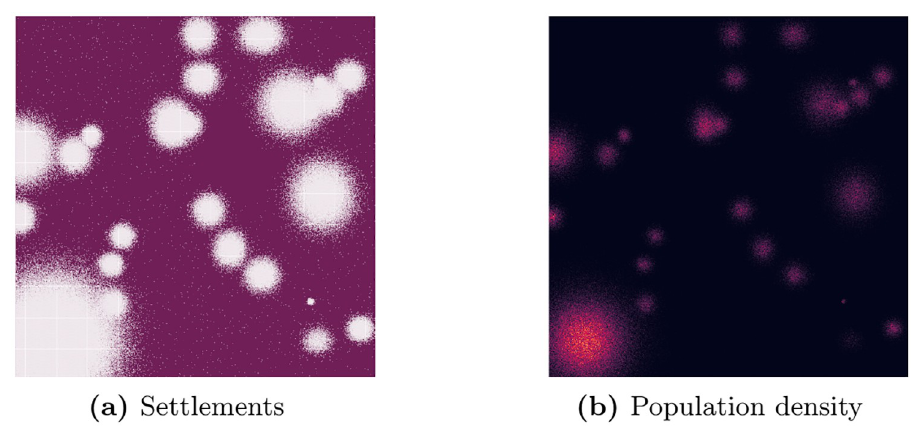
Fig 3. Simulation setup—Settlements. (a) shows locations of the built-up areas in a hypothetical country, while (b) shows the corresponding population density in these areas (the brighter the colour, the higher the population density).